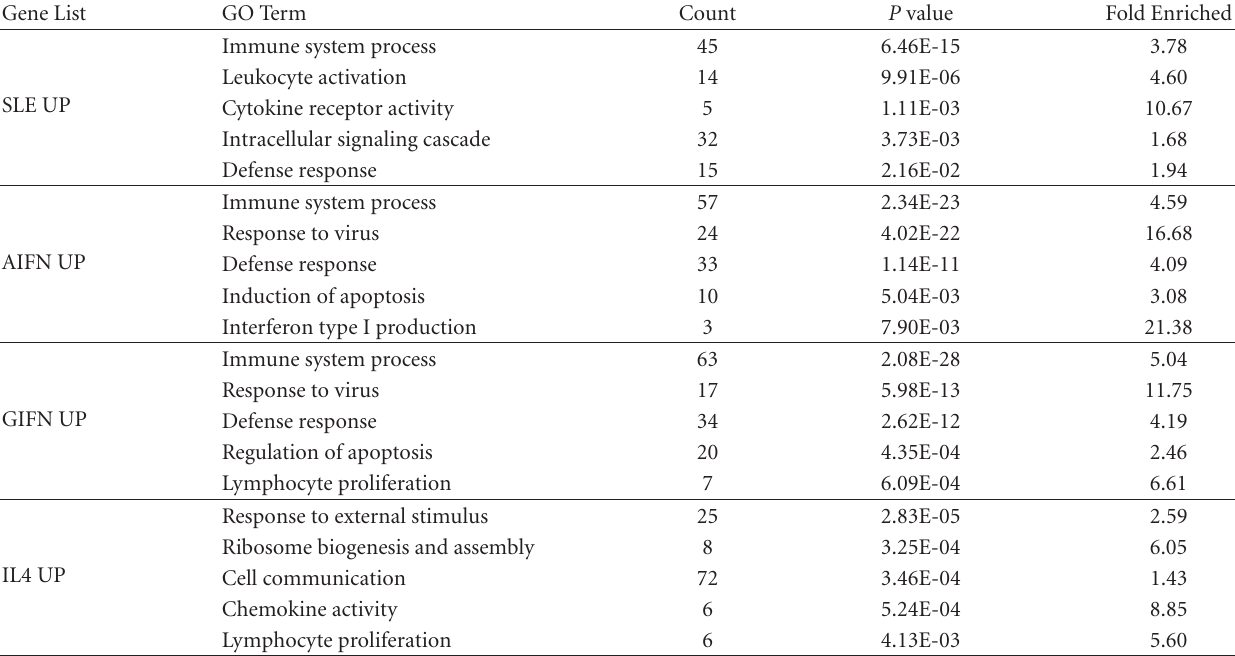
Table 1: DAVID analysis of SLE gene expression.